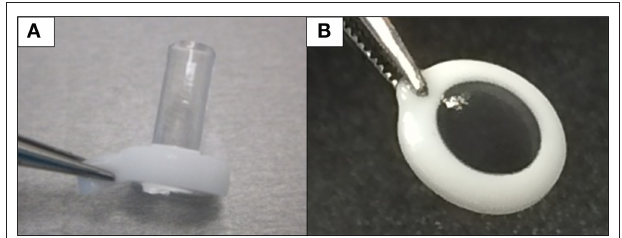
FIGURE 2 | Digital pictures of the AlphaCor TM produced by polymerisation of PHEMA to produce a transparent (optical) and white (skirt) PHEMA before (A) and after (B)